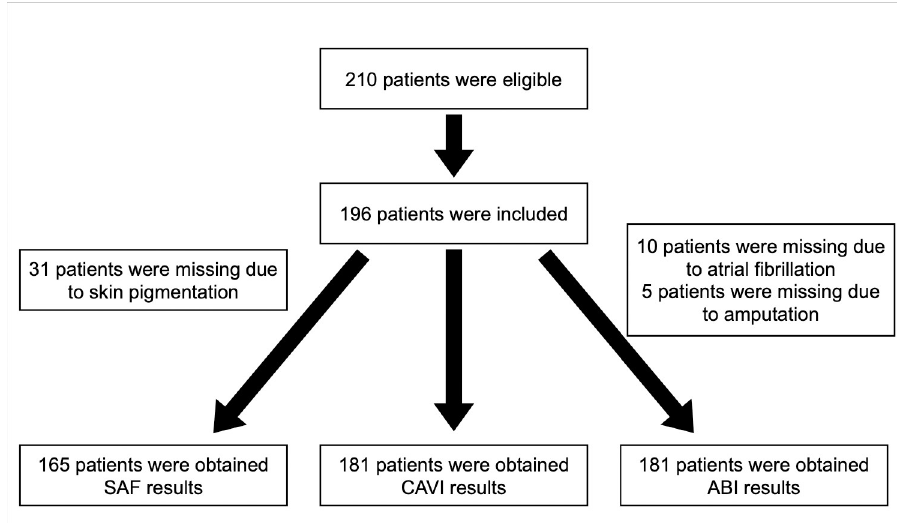
Fig 1. Study consort patient flow